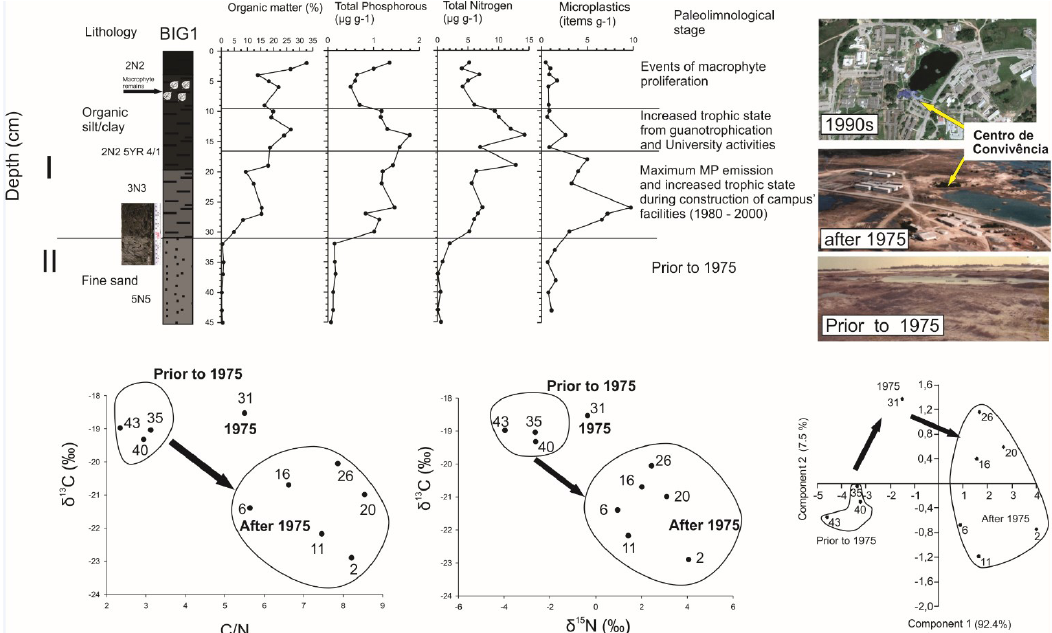
Figure 2. Lithology and vertical distribution of organic matter, total phosphorous, total nitrogen and MPs (upper four panels). Age is shown to the right of the plots, and photographs of the study area showing the environmental settings prior to 1975 AD and after 1975 are shown to the right. The lower panels show information on stable isotope data and C/N ratios and the PCA plot. The numbers next to each point indicate the core depth intervals in